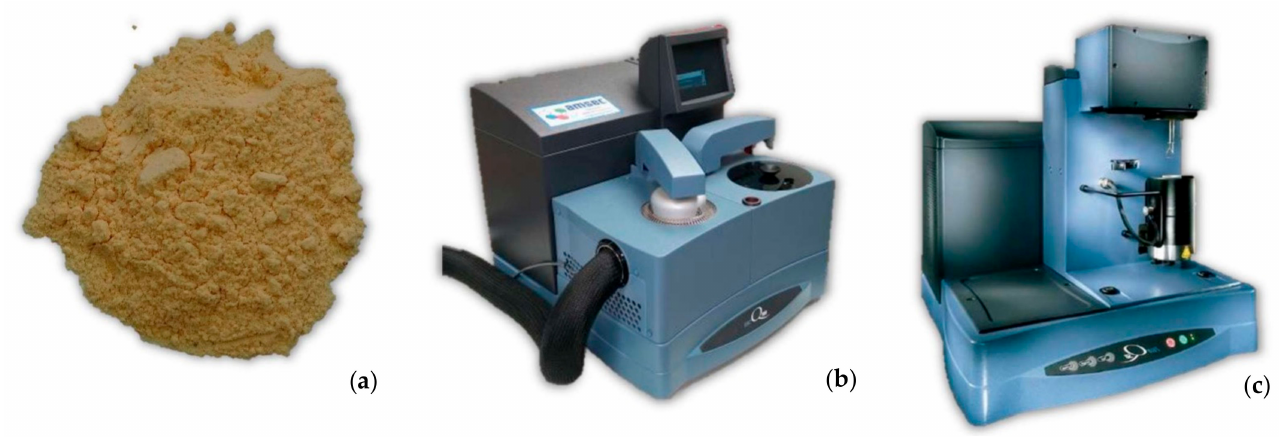
Figure 7. A-IX-1 explosive composition extracted from the PG-7VM warhead ( a ) to test on a differential scanning calorimeter DSC Q100 ( b ) and thermogravimetric analyzer TG Q50 ( c